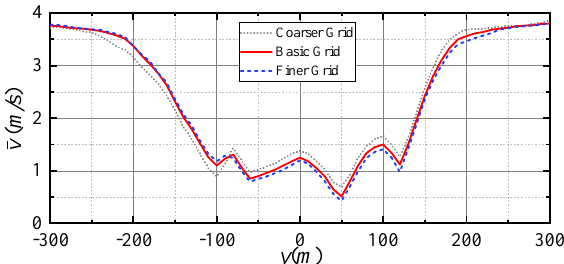
Figure 4. Time averaged velocity magnitude distribution in the wake of the building group ( x = 150m) at horizontal plane of z = 2m for the basic grid, finer grid and coarser grid.